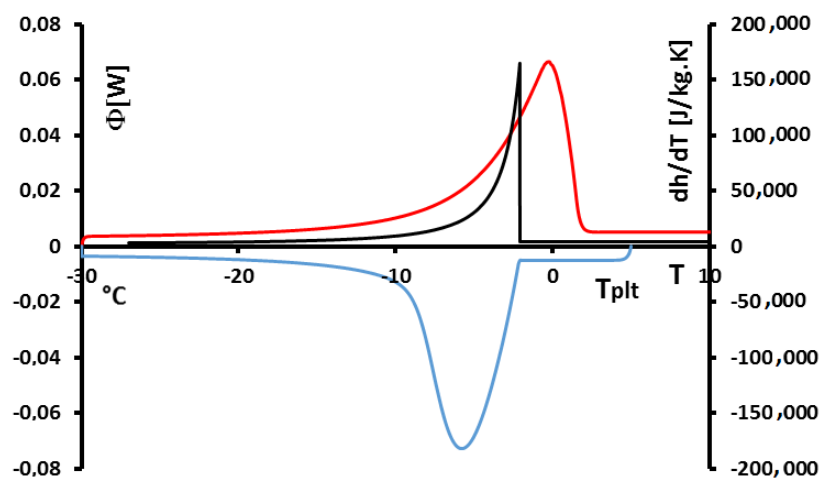
5 K/min (blue) and for − d h (black) versus the local temperature T d T